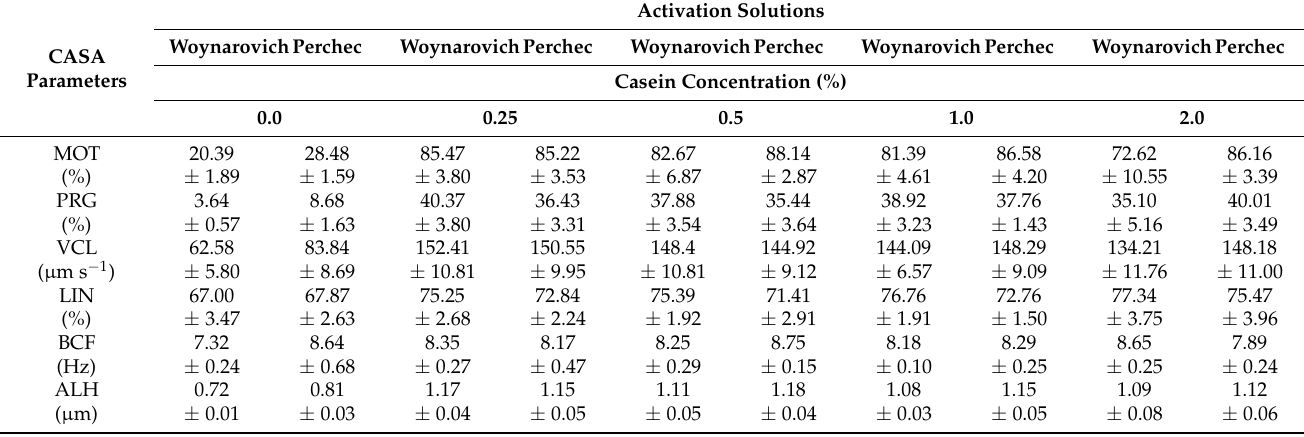
Table 3. Detailed characteristics (mean ± SEM) of CASA parameters after ide ( Leuciscus idus , n = 5) sperm motility activation with Woynarovich and Perchec solutions supplemented with different casein